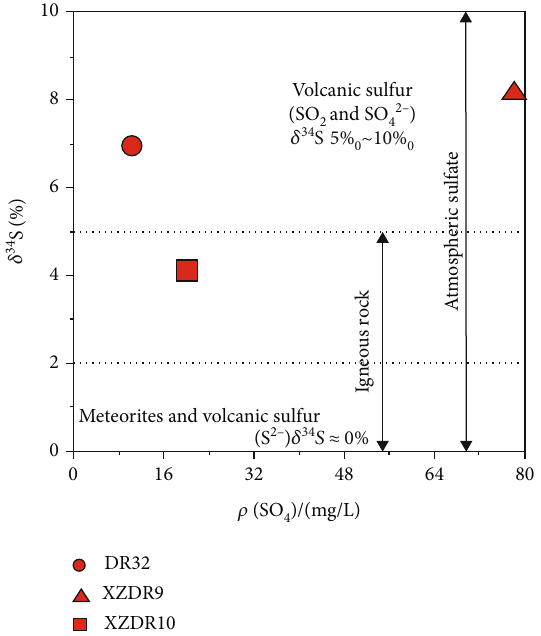
Figure 4: δ 34 S- ρ SO 42 − plot of geothermal water in the study